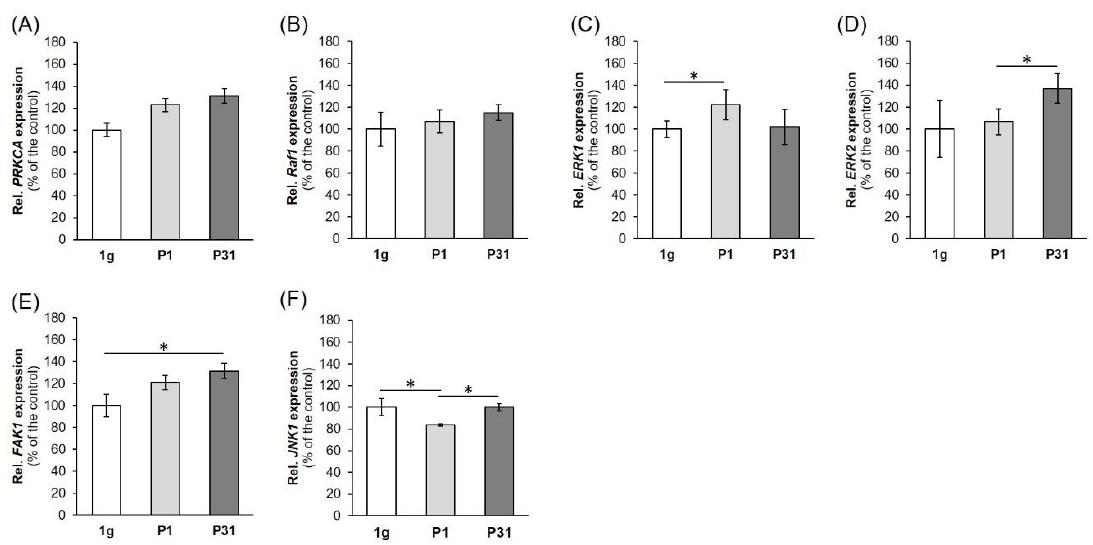
Figure 8. Expression of genes: ( A ) PRKCA , ( B ) Raf1 , ( C ) ERK1 , ( D ) ERK2 , ( E ) FAK1 , ( F ) JNK1 , involved in cancer progression and metastasis. 1 g : ground control; P1: parabola 1; P31: parabola 31. The data are given as mean ± standard deviation. * p < 0.05 vs. 1 g -control.